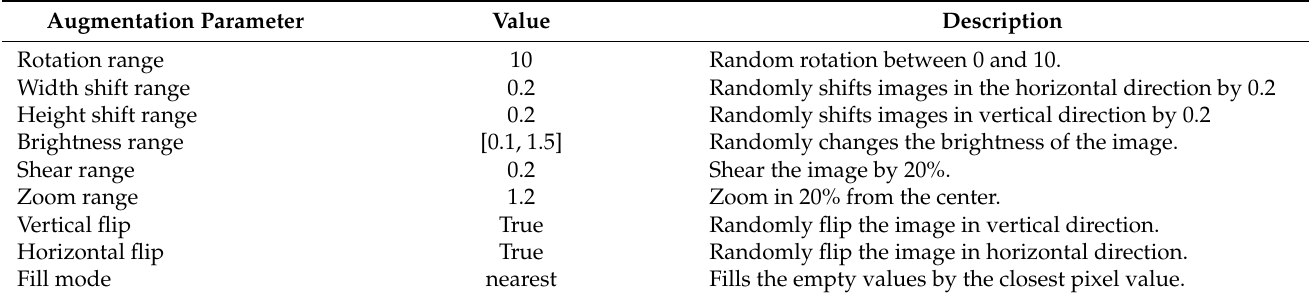
Table 2. Data augmentation parameters.